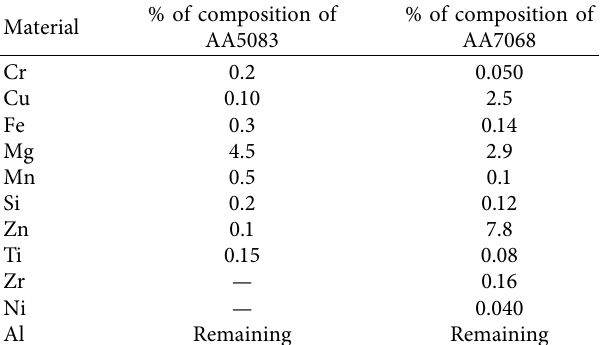
Table 1: Chemical composition of AA7079 and AA8050.